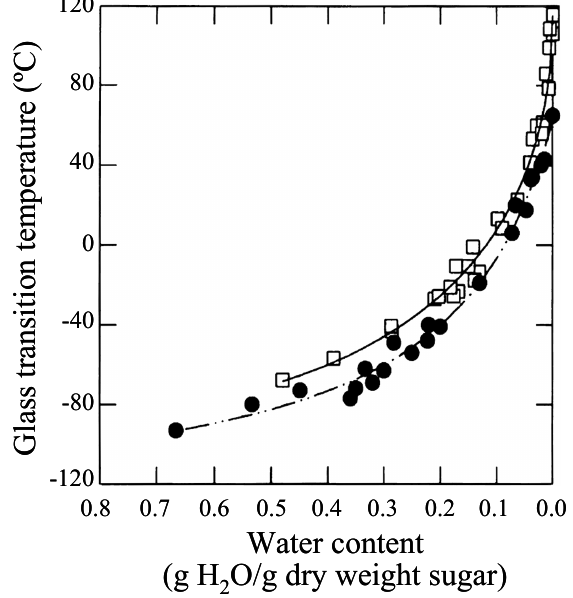
of sucrose (closed circle) and trehalose (open square), Figure 2. State diagrams for T g reproduced courtesy of Professor L. M. Crowe and the Biophysical Society